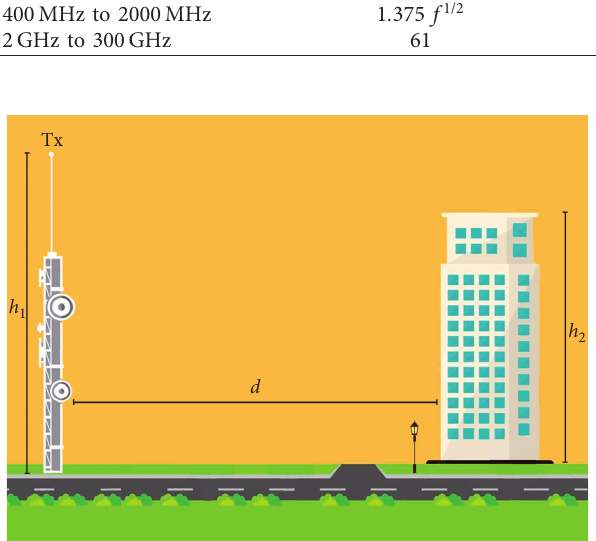
Figure 1: Representation of the studied scenario. Tx abbreviation stands for “transmitter tower.” Variable d is the horizontal distance between the measured building and the transmitter tower (not to be confused with the distance of the receiver equipment from the transmitter source). Variable h is the height of the transmitter 1 represents the height of the measured building. tower and h 2